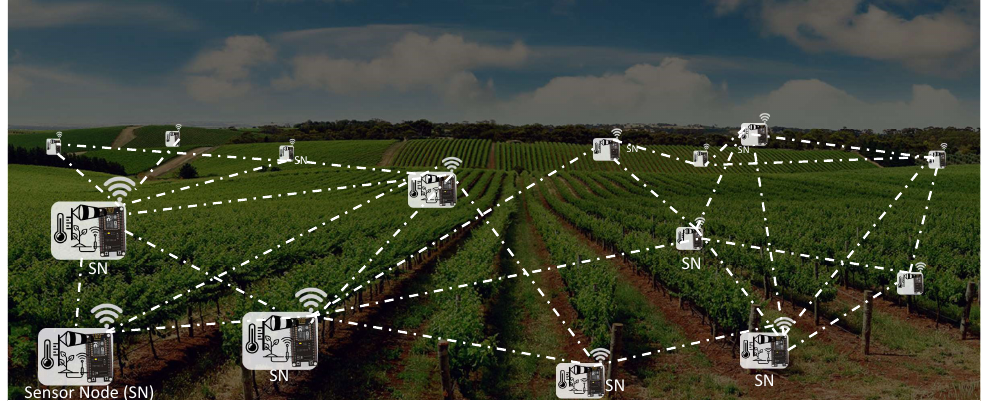
Figure 1. High level presentation of wireless sensor